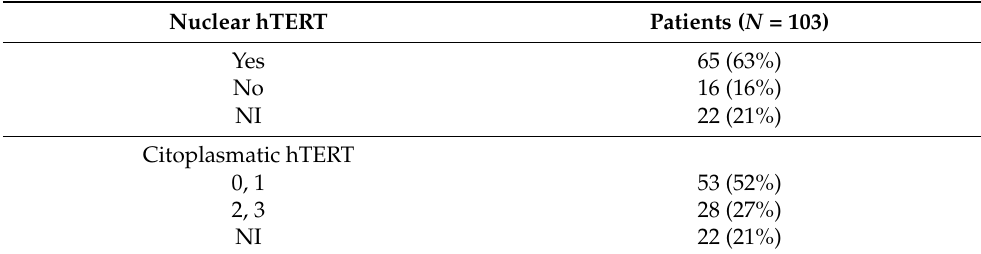
Table 2. Nuclear and cytoplasmic labeling of